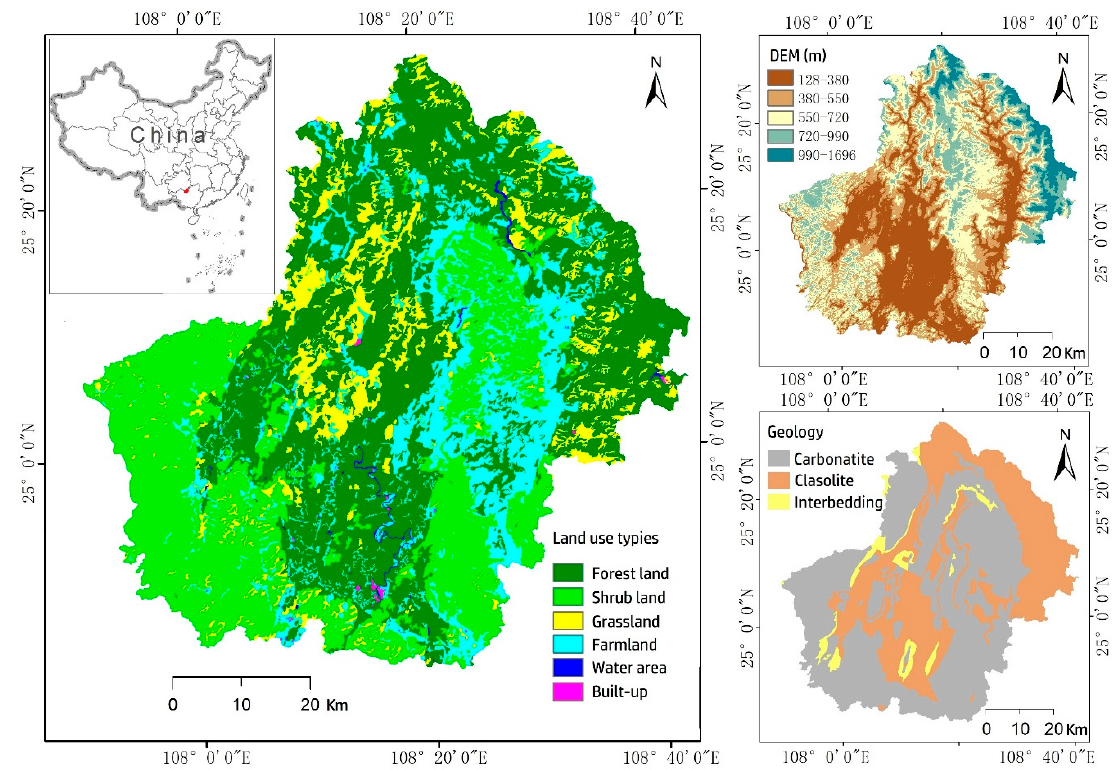
Figure 1. Location of the study area (Huanjiang County) and its land use and cover in 2015. Elevation and geology are in the image background.